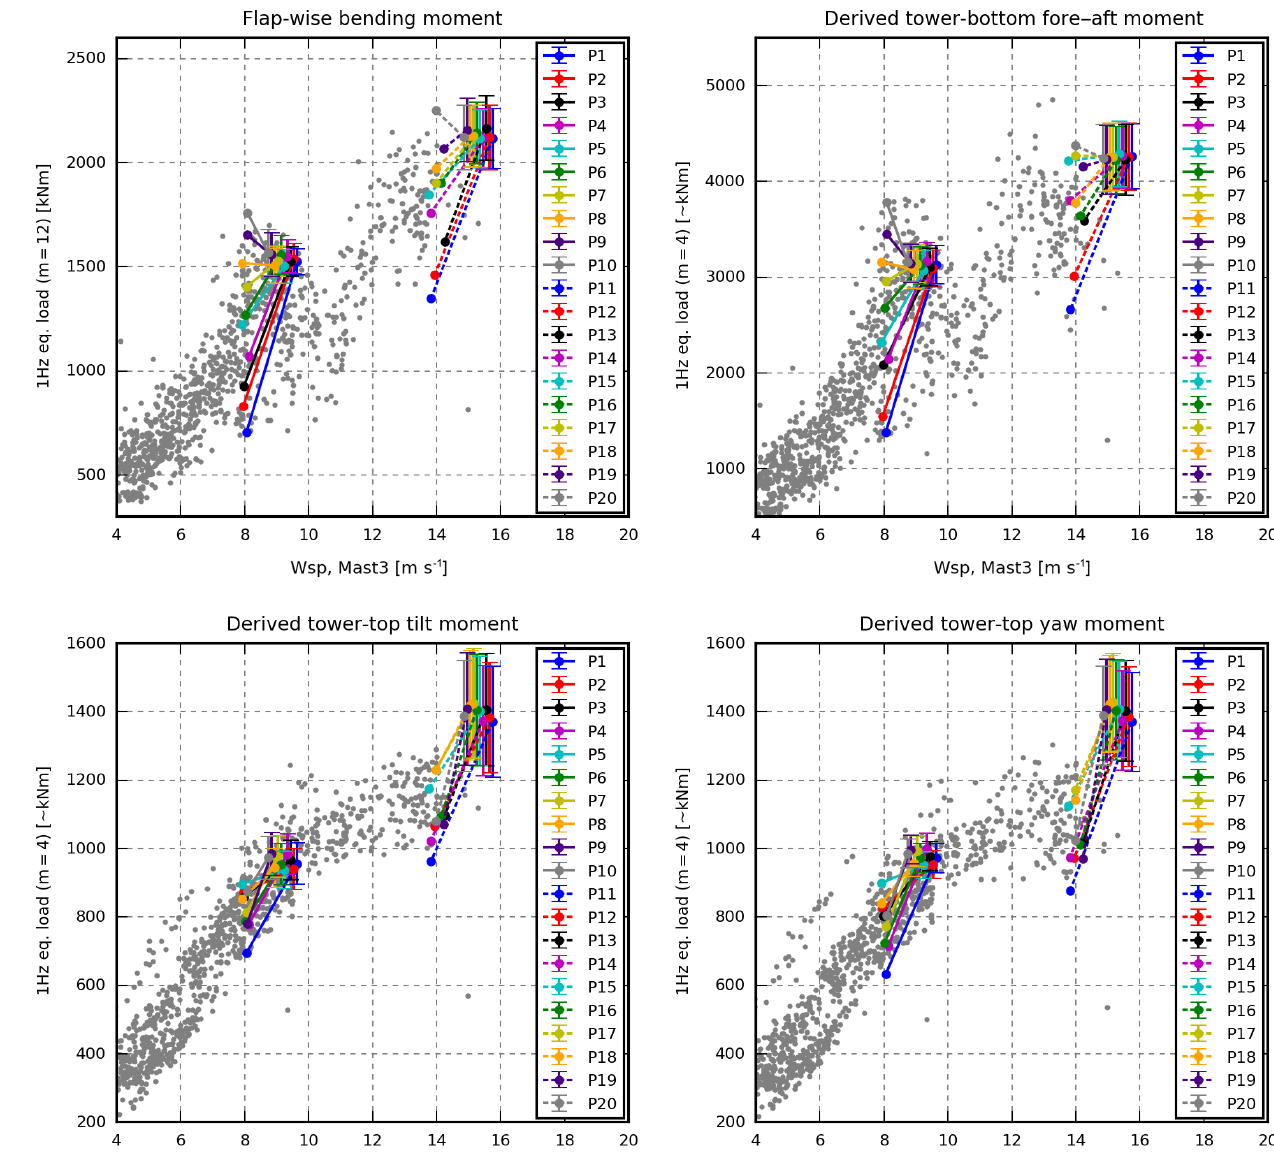
Figure 14. Case 1. Site average turbulence intensity and shear (wind-speed trend neglected). For interpretation see Fig.